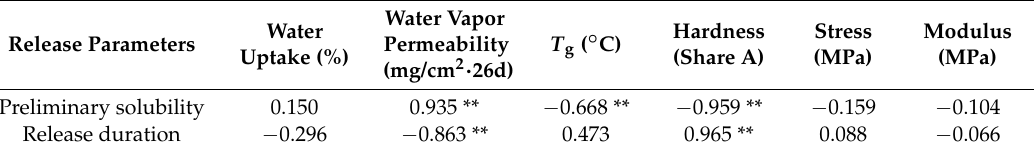
Table 3. Pearson correlation coefficients between the properties of coatings and the controlled-release parameters of